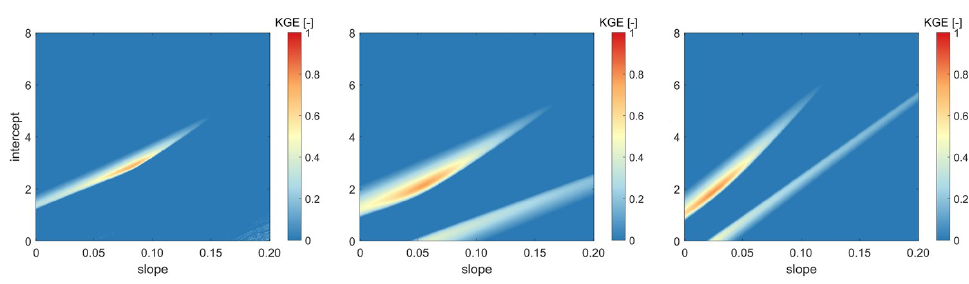
Figure 6. Kling–Gupta Efficiency (KGE) values for a range of linear regression models (slope a ranging from 0.001 to 0.20 and intercept b ranging from 0 to 8), obtained by inverting the Oh model for HH ( left ) VV ( middle ) and HV ( right ) normalized bias-corrected backscatter coefficients.